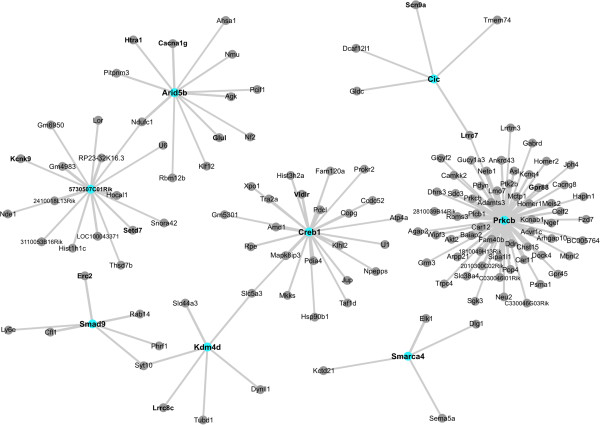
WGCNA generated correlations containing transcription factors found in the module correlated with the postpartum phenotype. Of the two modules generated using WGCNA, one was highly correlated with the postpartum phenotype. All gene-to-gene correlations involving transcription factors were selected from the module associated with the postpartum phenotype, and the network was visualized using Cytoscape. Edge width and size are proportional to the weight of the correlation between two genes. Blue nodes with bolded text are highly significant (nominal p < 0.01) transcription factors, co-factors, and chromatin remodeling factors correlated to a subset of other variable genes (nominal p < 0.05) from the microarray. Bolded text with gray nodes are genes found in other enriched gene lists, and include genes linked to mental health disorders, CNS development, and ion channel activity. Some transcription factors were also found in gene lists linked to mental health disorders, CNS development, and ion channel activity, but have been marked as transcription factors for this visualization. A full list of nodes and the weighted interactions for these genes can be found in Additional file 4.